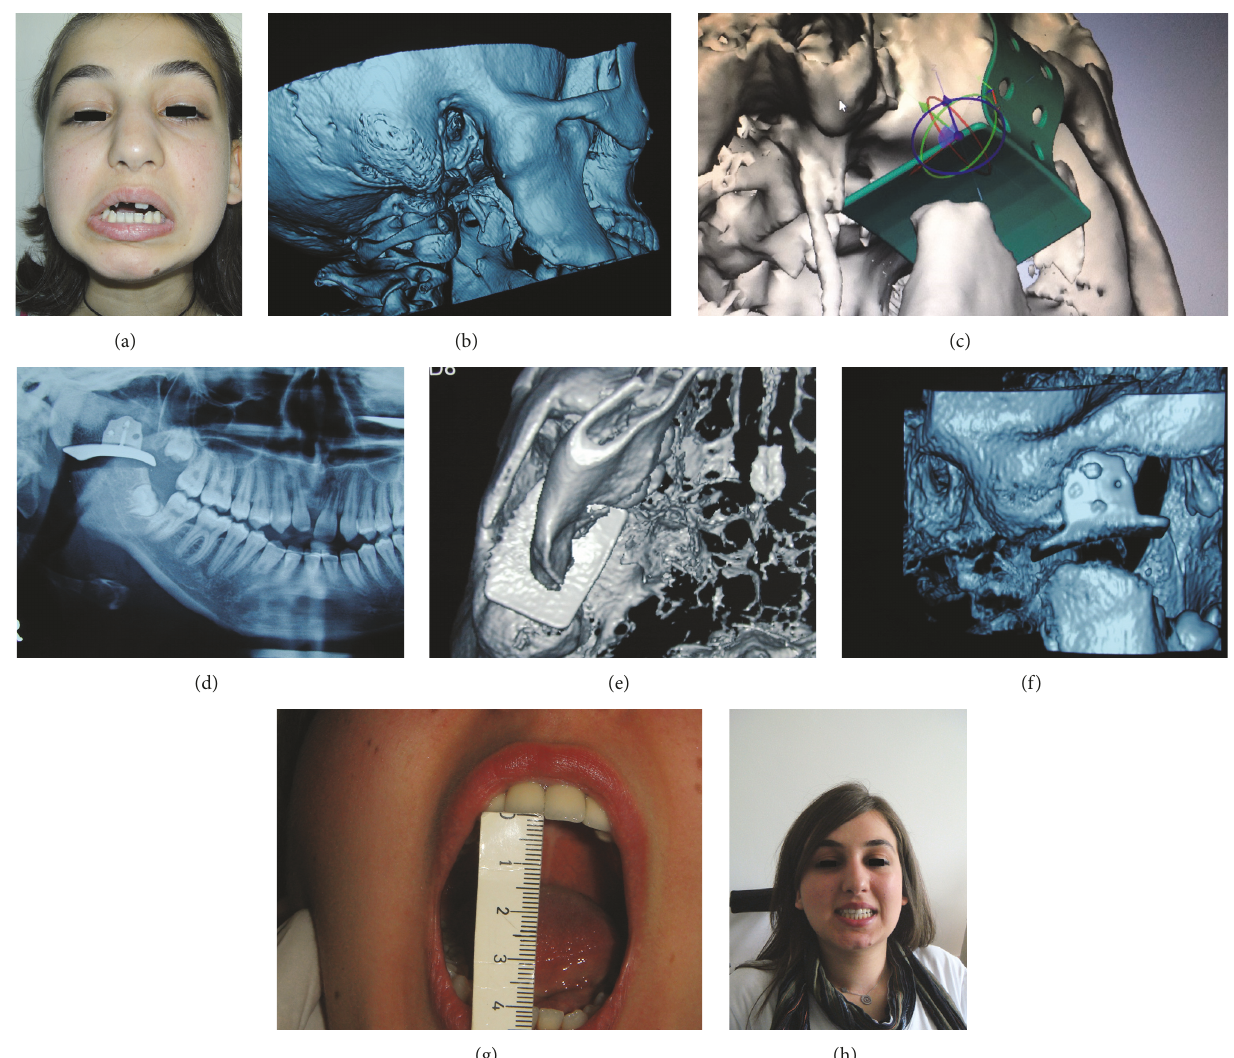
Figure 2: (a) The patient (Case 1) is not able to open her mouth due to reankylosis. (b) CT reveals reankylosis at the right TMJ five years after the first surgical treatment. (c, d) Panorex shows horizontal resection of the ramus via subankylotic approach. (e) The prosthesis creates a barrier to prevent reankylosis. (f) Complementation of the neoformation of the condyle two years after surgery. (g) Mouth opening, six years after surgical treatment. (h) Facial appearance after surgical and orthodontic